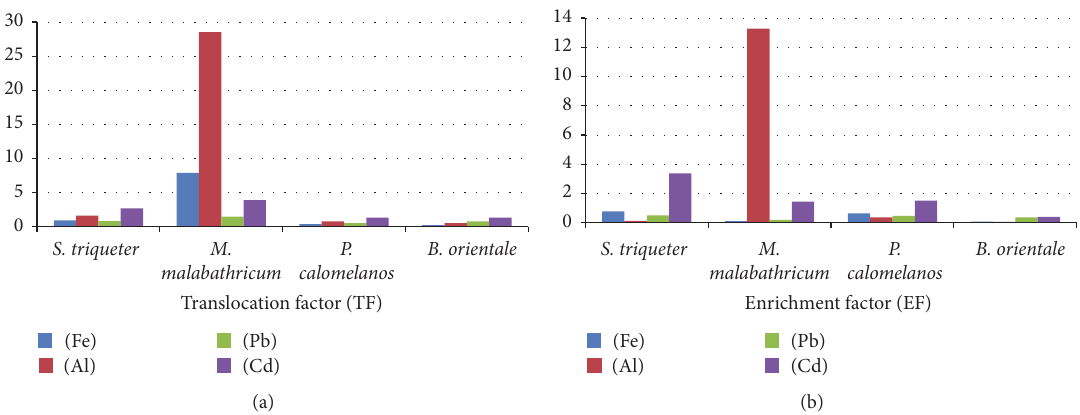
Figure 3: Translocation factor (TF) and enrichment factor (EF) for investigated plant